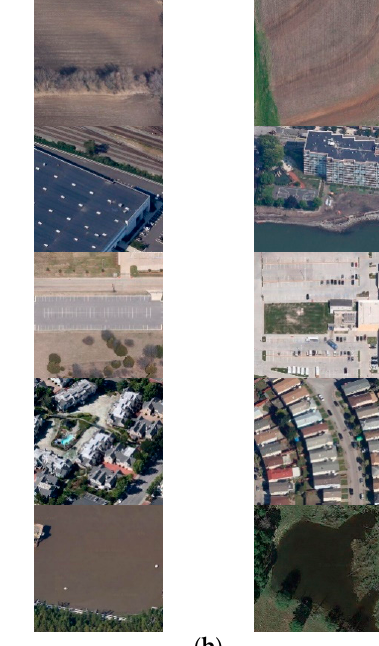
Figure 14. Some of the classification results of SGNAS and other models in the cross-domain scene dataset of UCM → RSSCN7. The first, second, third, fourth, fifth, sixth, and seventh rows correspond to the scene classes of farmland, forest, grassland, industrial region, parking lot, residential region, and river and lake in the RSSCN7 dataset, respectively. ( a ) Correctly classified images for all models. ( b ) Images classified correctly by SGNAS, but incorrectly classified by other models were used for comparison.